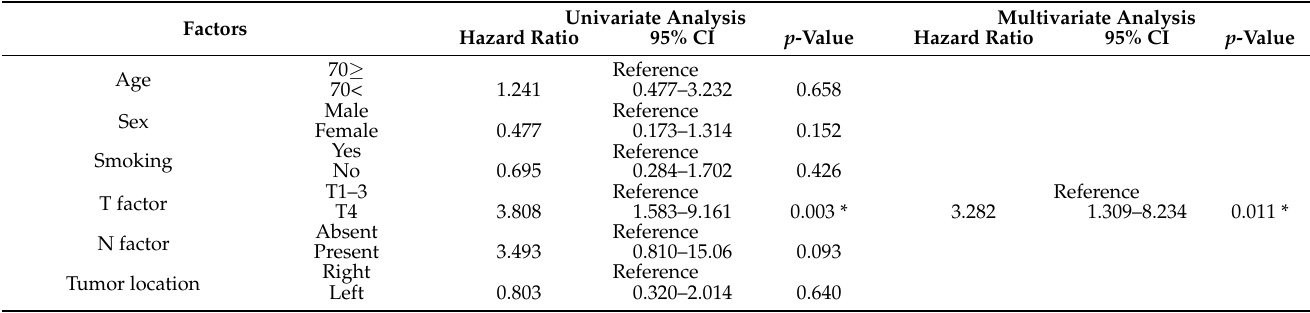
Table 2. Univariate and multivariate analysis of clinicopathological factors affecting recurrence-free survival rate following surgery in 98 CRC